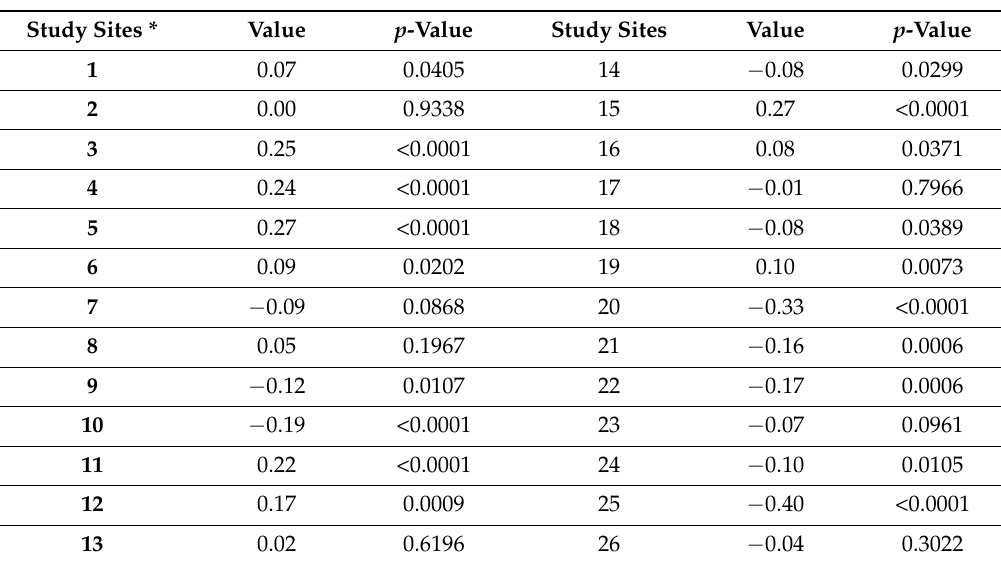
Table 6. Random coefficients ( δ m ) of height adjustment model for CHM.